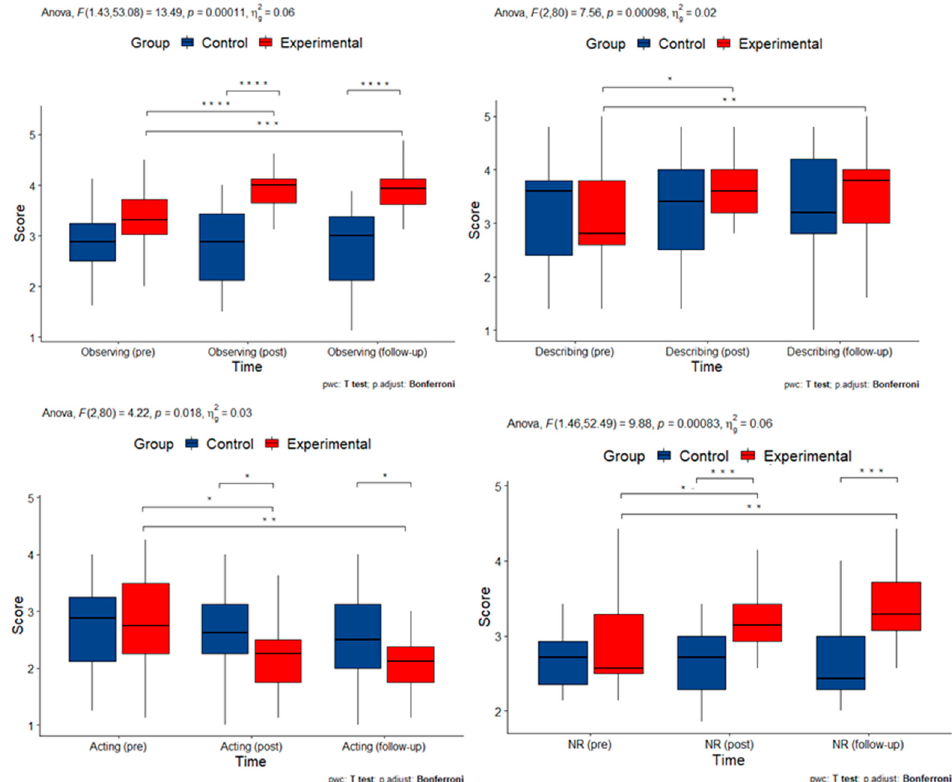
Figure 5. Box plots of measurements of mindfulness-like traits with statistically significant interac- tions (pre: pre-intervention; post: post-intervention; NR: Non-reactivity subscale). Asterisks denote statistically significant pairwise comparisons. Table 4. p -values for significant interaction of group and time for methylation of candidate gene amplicons. Table contains only amplicons where the average DNA methylation values could be calculated from available data. Statistically significant p -values are marked in